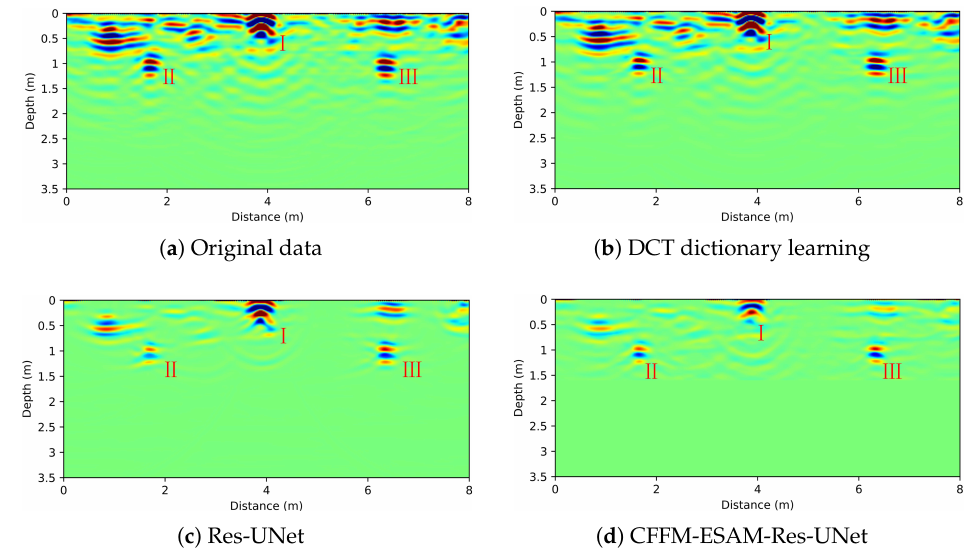
Figure 14. RTM imaging results of experimental GPR recordings after diferent methods